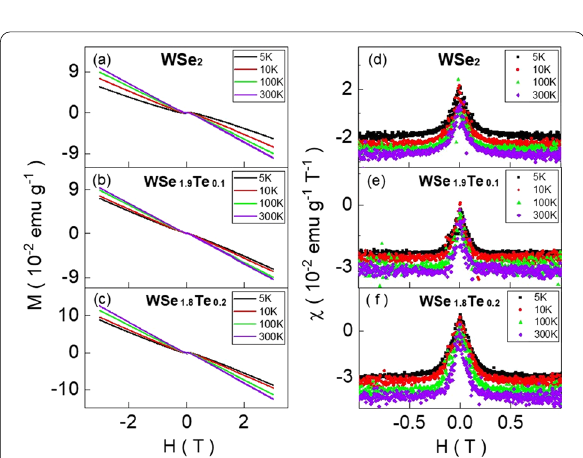
Fig. 3 a – c show the magnetization as a function of magnetic field. They show paramagnetism at low magnetic field and diamagnetism at high magnetism at different temperatures. The diamagnetism is negatively proportional to the magnetic field. d – f show susceptibility peaks at a function of magnetic field. It reveals peaks at zero magnetic field, and the susceptibility peaks show weak temperature dependence from 5 to 300